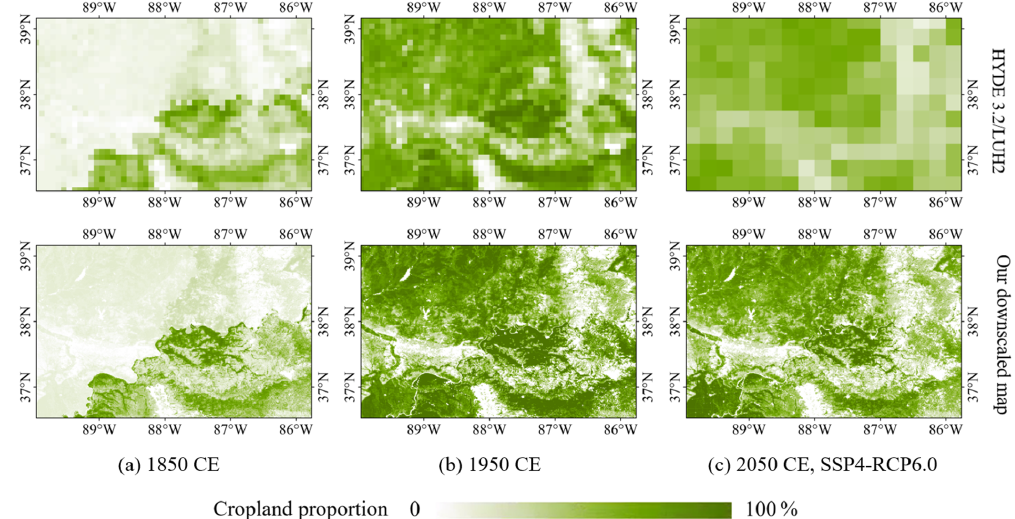
Figure 5. Cropland distribution of the region shown in Fig. 4c for different years (a–c) . The location of image center points is Kentucky, USA (37 . 846 ◦ N, 87 . 861 ◦ W).